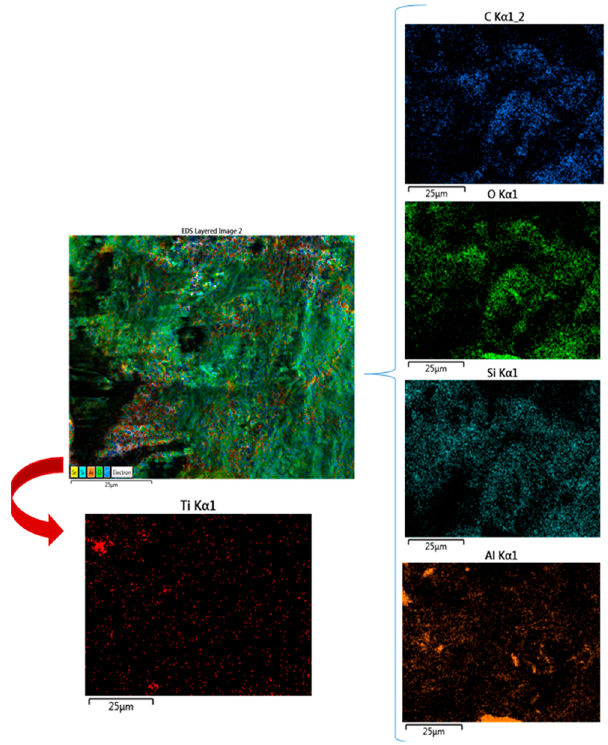
Figure 5. Elemental mapping for the 3D-printed nanocomposite.